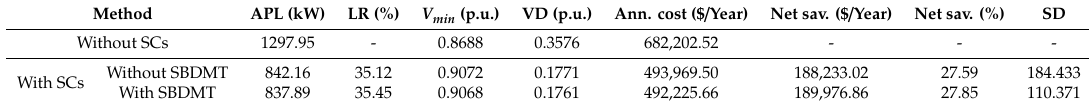
Table 15. Comparison of PODESCA’s results for the 118-bus system without and with reducing the search space by